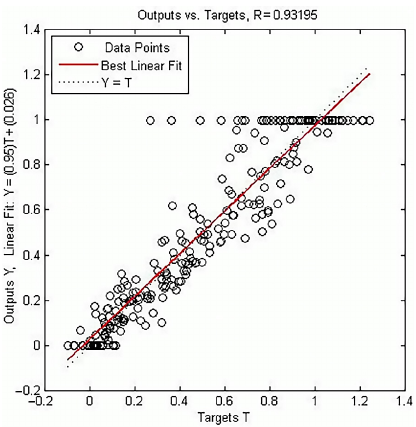
Fig. 3. Artificial neural network fit during validation Source :